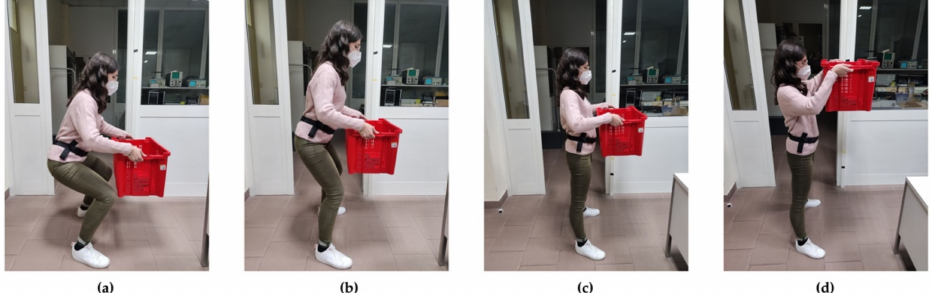
Figure 3. Lifting phases of the lifting task: picking point ( a ) with squatting technique, intermediate points ( b , c ) with trunk extension, and destination point ( d ) up to the final height, and then restart the